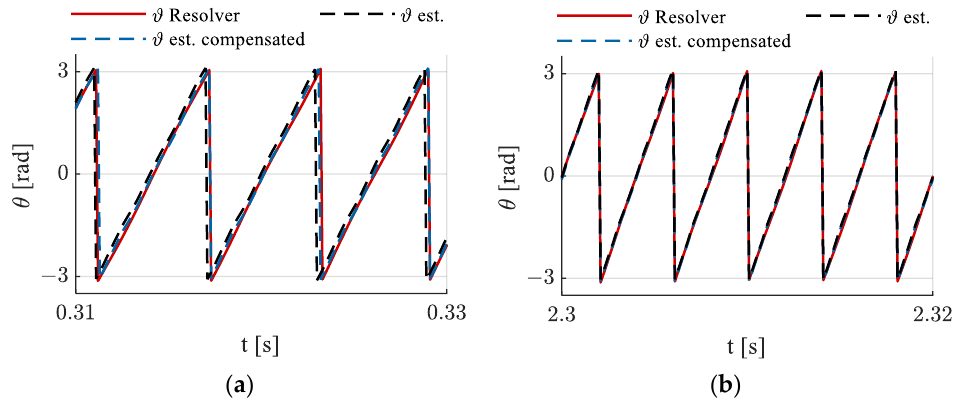
Figure 19. Electrical rotor position: ( a ) startup transient of the emergency three-phase operation at approximately 2000 rpm; ( b ) no-load steady state of the emergency three-phase operation at 3000 rpm.